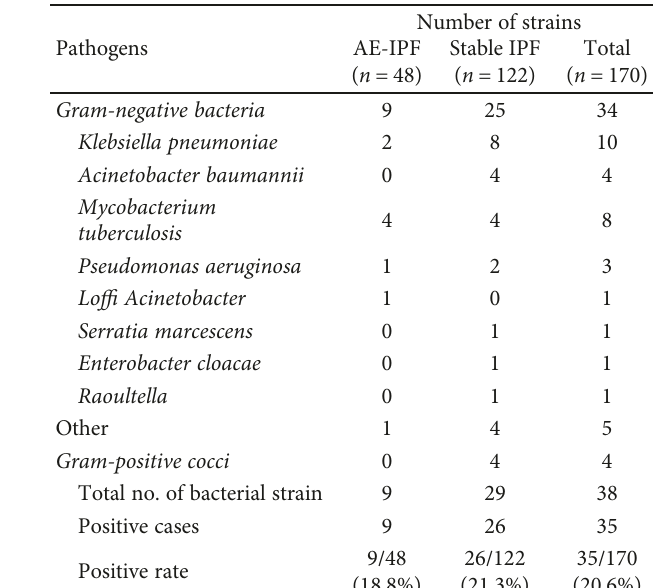
Table 4: Pathogens in sputum of IPF